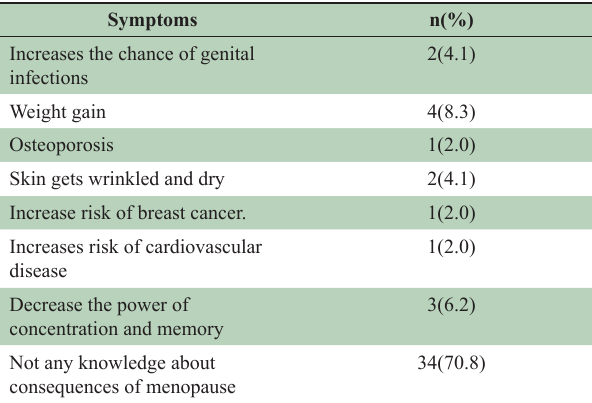
Table-IV: Knowledge about Consequences of Menopause .